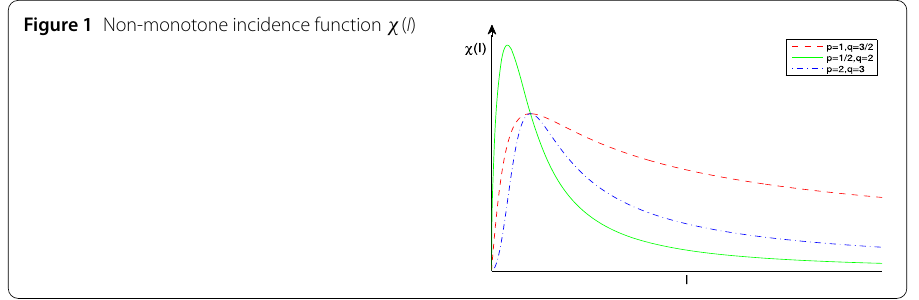
Figure 1 Non-monotone incidence function χ ( I